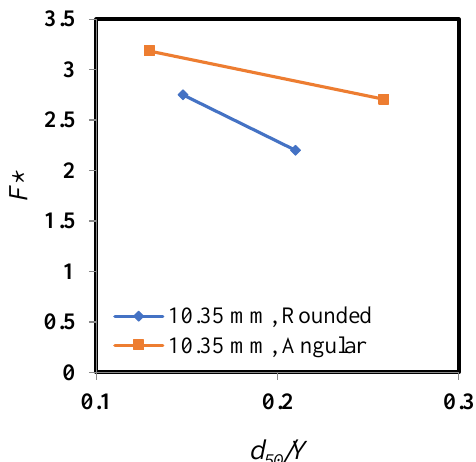
Figure 6. Comparison between particle Froude number for uniform rounded and angular sediments of 10.35 mm.